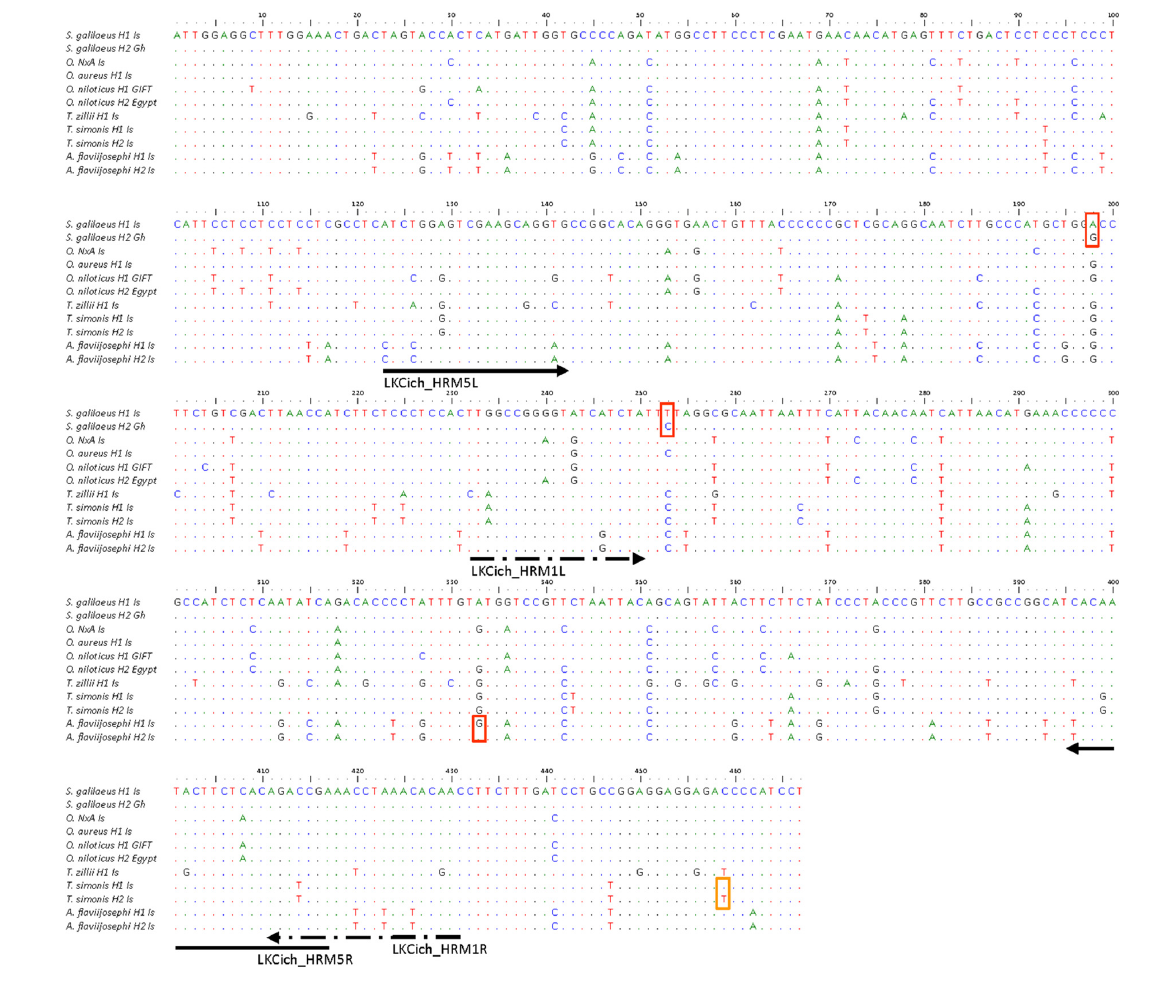
FIGURE1 Multiple alignment of the 11 COI haplotypes used for developing the cichlid species identification method. On the left are the species and haplotype names. Variable bases relative to the top sequence are shown by their letter. Underneath the alignment marked are name, position, and direction of the PCR primers. Red and orange small boxes show positions within and outside, respectively, the HRM primer amplicon that are polymorphic between haplotypes of the same